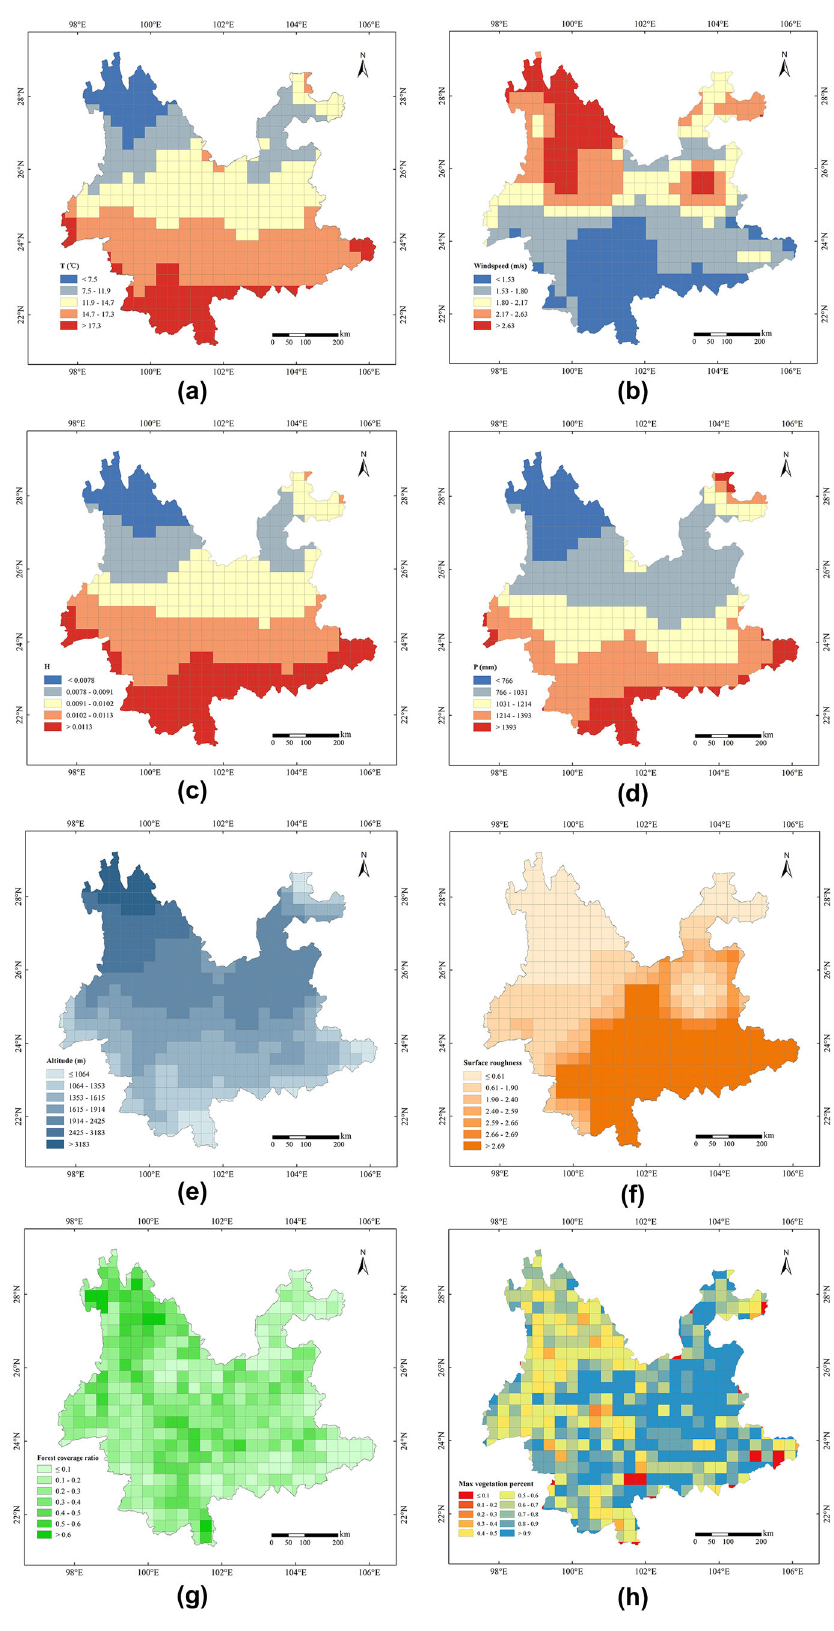
and their spatial distribution. a Annual average of temperature, b annual average of windspeed, c annual average of humidity, d annual average of precipitation. e altitude, f surface roughness, g forest coverage ratio, h